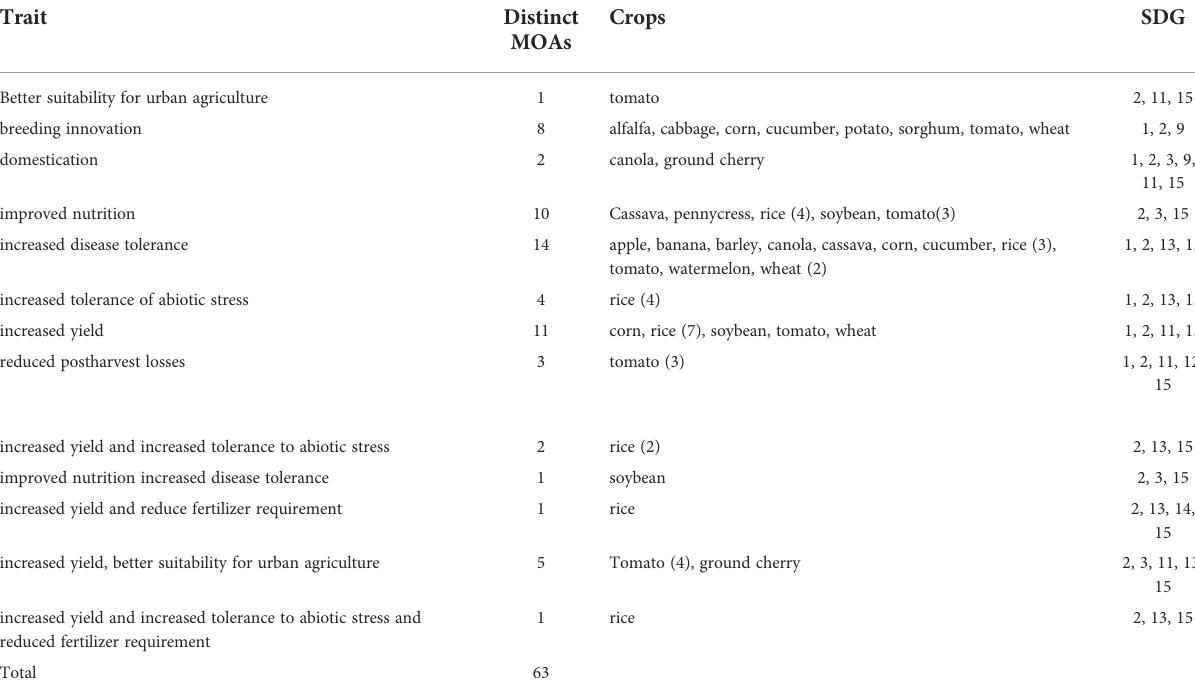
TABLE 1 Crops that may contribute to sustainable agriculture that could potentially qualify for USDA regulatory exemption. Trait Distinct